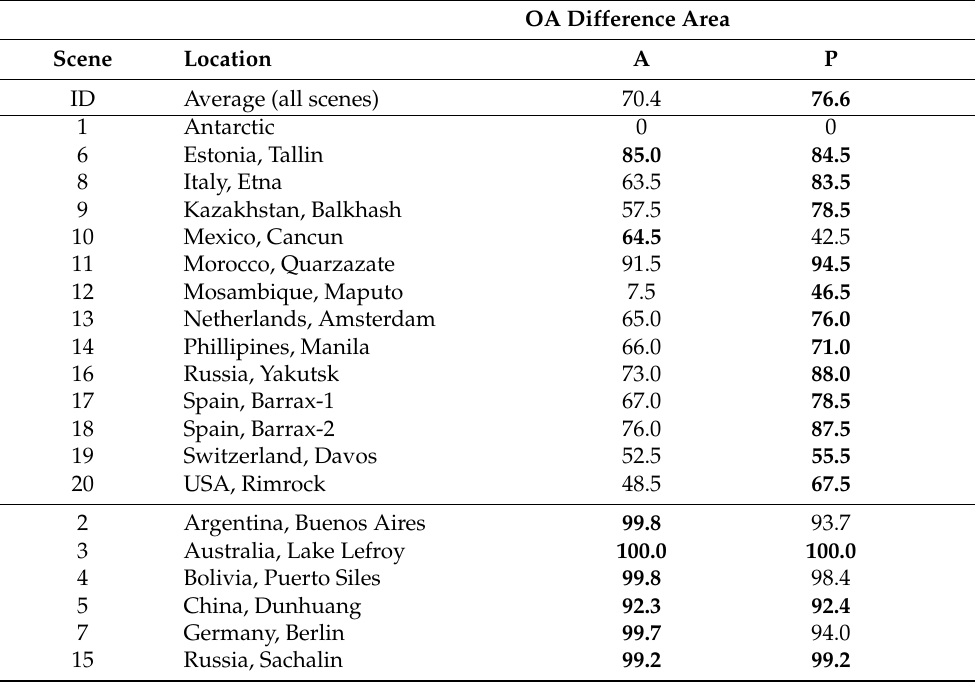
Table 3. Summary of the cloud shadow class’s overall accuracy (percent) (A = ATCOR, P = PACO; bold face numbers indicate the best